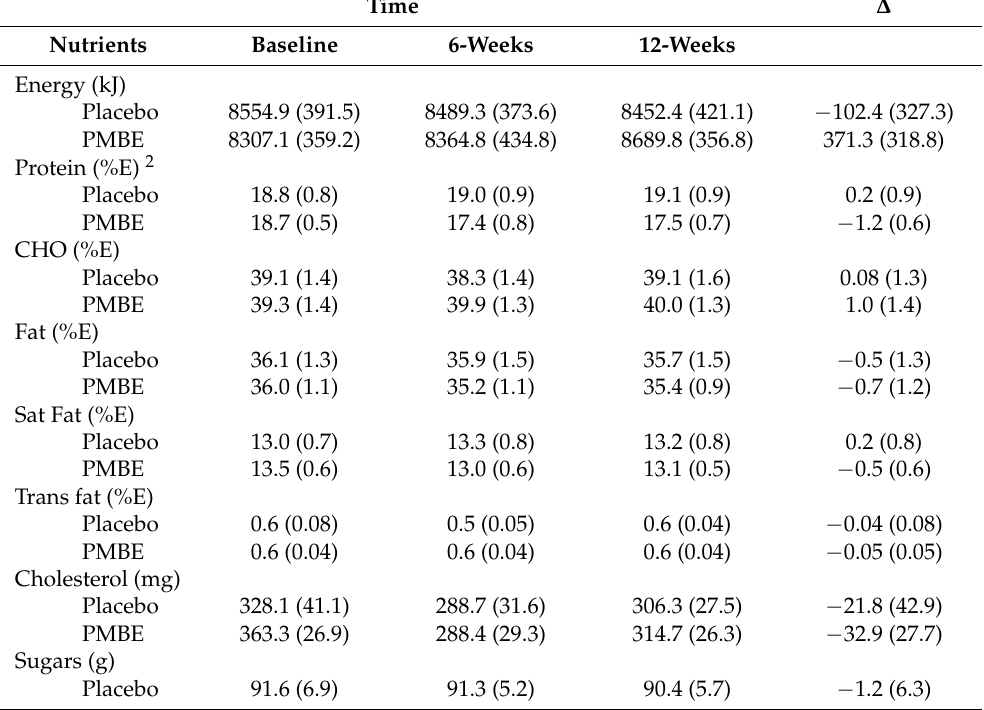
Table 3. Background nutrient intake in the placebo and PMBE group at baseline, 6 weeks and 12 weeks (post-intervention) and mean change from baseline to 12 weeks post-intervention ( ∆ ) 1